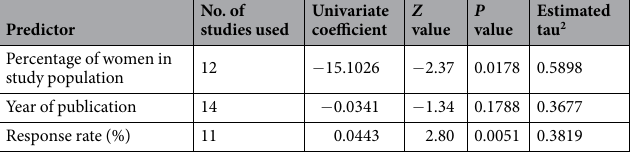
Table 3. Results for meta-regression on studies on lifetime prevalence of